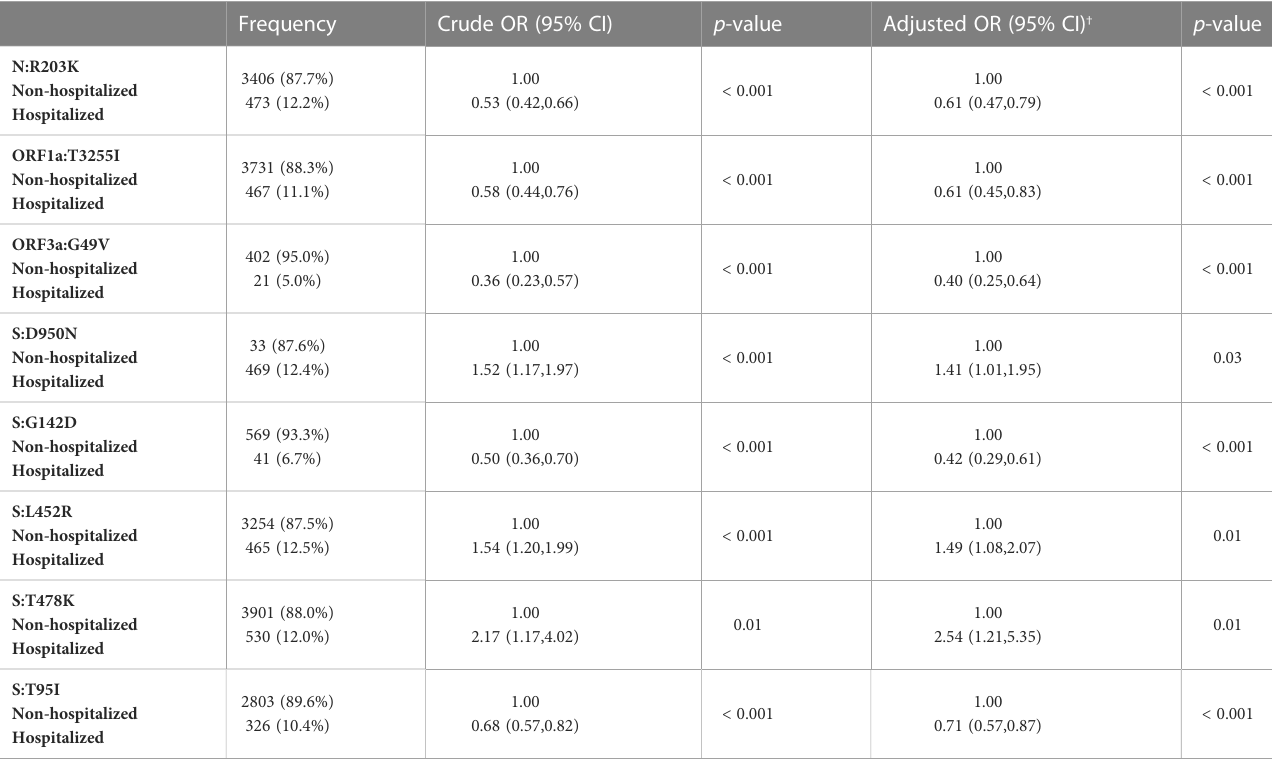
TABLE 4 Mutations associated with hospitalized cases due to